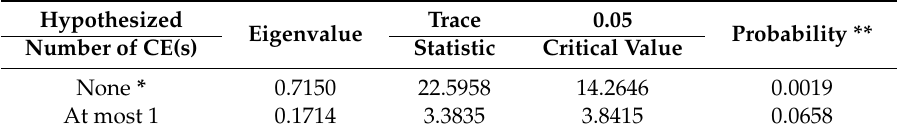
Table 3. Unrestricted Cointegration Rank Test (Maximum Eigenvalue).